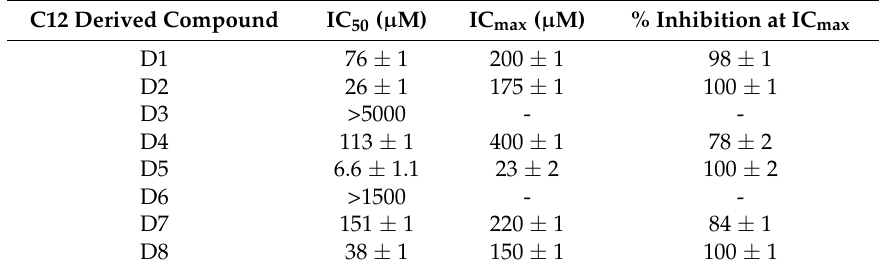
Table 2. Effect of C12 derived hits on the NADPH-dependent DCPIP diaphorase activity of Xcc FPR. Kinetic measurements carried out at 25 ◦ C, in 50 mM Tris/HCl, 2% DMSO, pH 8.0, using 20 nM Xcc FPR, with saturating DCPIP (95 µ M) and NADPH (50 µ M), and varying the compounds concentration in the 0–800 µ M range ( n > 2, means ± SD). IC 50 and IC max stand for the concentration of the compound causing 50% enzyme inhibition and maximal inhibition, respectively. All shown Xcc FPR inhibition percentages at IC max are statistically significant (***, p < 0.0001). C12 Derived Compound IC 50 ( µ M) IC max ( µ M)